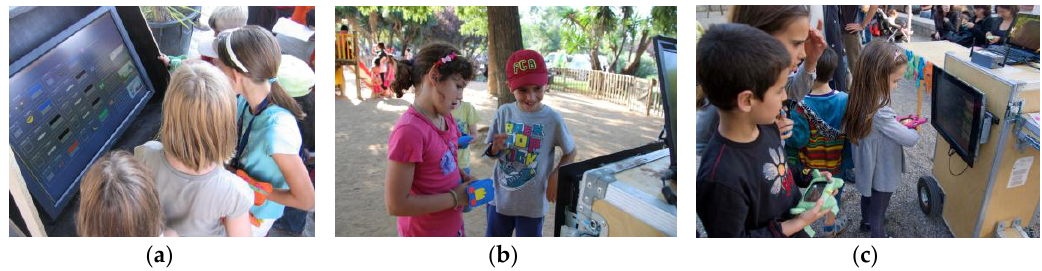
Figure 5. Kids looking the score in the server screen ( a – c ). Details of the bracelet with the integrated RFID tag ( b ).